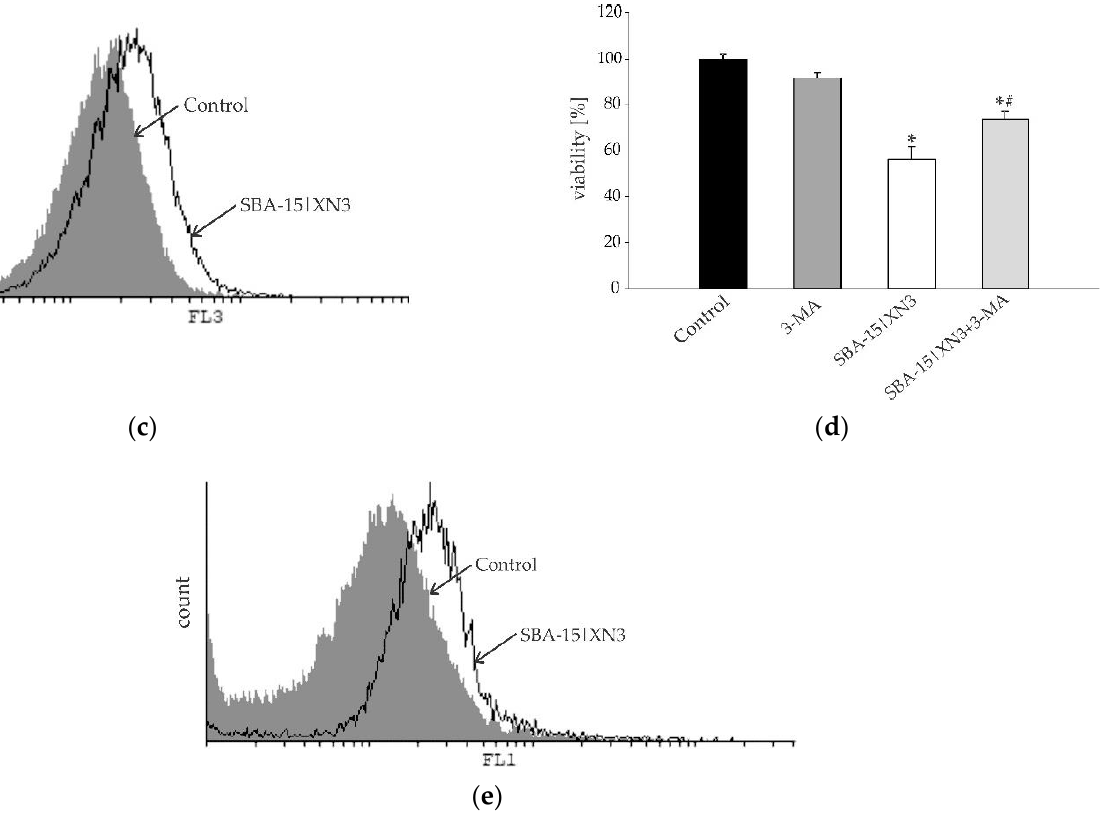
Figure 5. Inhibition of cellular proliferation and promotion of autophagy without induction of caspase-dependent apoptosis in B16F10 melanoma cell culture determined using Ann/PI ( a ), ApoStat ( b ), AO ( c ) and CFSE ( e ) staining, all performed after 48 h of treatment with SBA-15|XN3 and subsequently analyzed by flow cytometry. Dot plots and histograms are representative ones selected from three repeated experiments. The induction of autophagic cell death exposed to MC 50 dose SBA-15|XN3 and 3-MA (in final concentration of 1 mM) for 48 h ( d ). Cell viability was determined by CV assay and expressed as a percentage of control values (untreated cells). The data are presented as mean ± SD obtained from three independent experiments. * p < 0.05 refers to untreated cultures; # p < 0.05 refers to SBA-15|XN3 treated cultures.